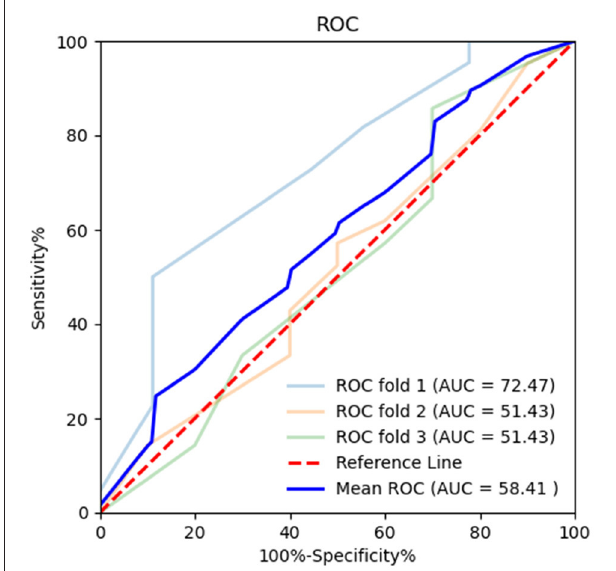
FIGURE 6 | Receiver operating characteristic (ROC) curve of MoCA in k-fold cross-validation. K-fold cross-validation was used to evaluate the predictive performance of MoCA. The mean area under the curve (AUC) was 0.584, sensitivity 92.73%, and specificity 13.42%.